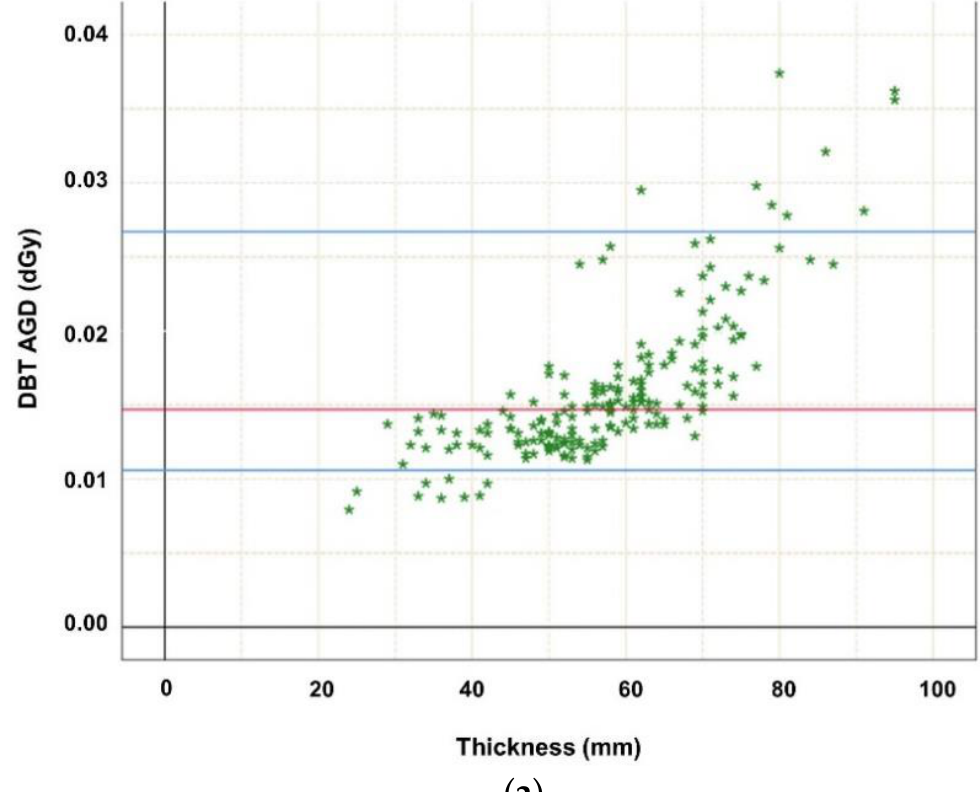
Table 2. Mean average glandular dose (MGD), standard deviation (SD), and interquartile range (IQR) per each view and modality.